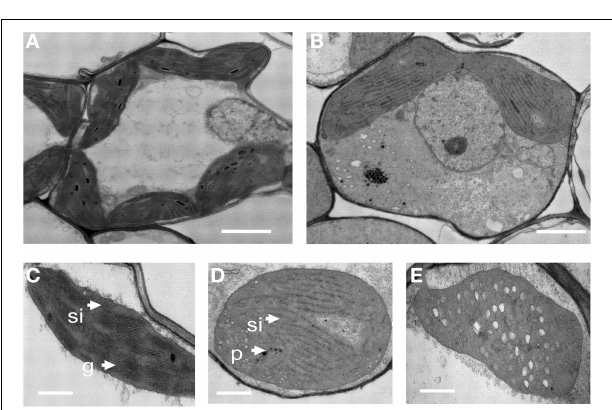
FIGURE 3 | Transmission electron microscopic images of chloroplasts from 1-month-old wild-type and oscdm1 plants. (A) Wild-type mesophyll cells. (B) The mesophyll cells of oscdm1 plants. (C) Wild-type chloroplasts. (D,E) The chloroplasts of oscdm1 plants. The chloroplasts of the wild-type plants had abundant, well-ordered membrane stacks, whereas the chloroplasts of the oscdm1 mutant had almost no normal stacked membranous structures or grana (D) . The mutant chloroplasts also exhibited vacuolation (E), p, plastoglobule; g, grana stack; sl, stroma lamellae; v, vacuolation. Bar = 1 µ m in (A,B) , and 100nm in (C–E)